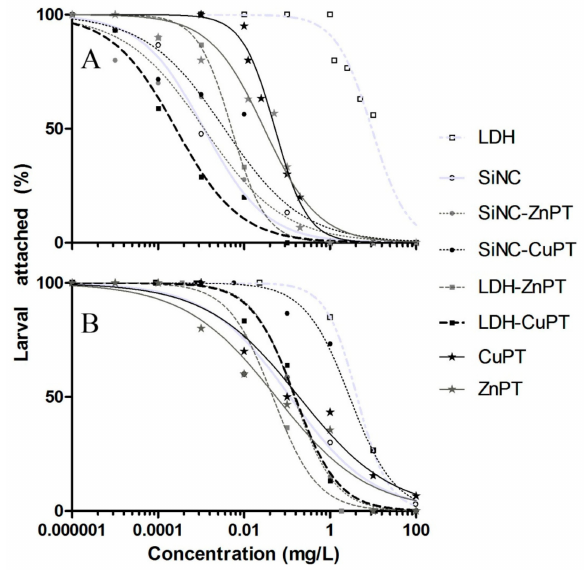
Figure 4. Attachment of Mediterranean (( A ), MED) and Red Sea (( B ), RED) larvae of Bugula neritina at different concentrations of